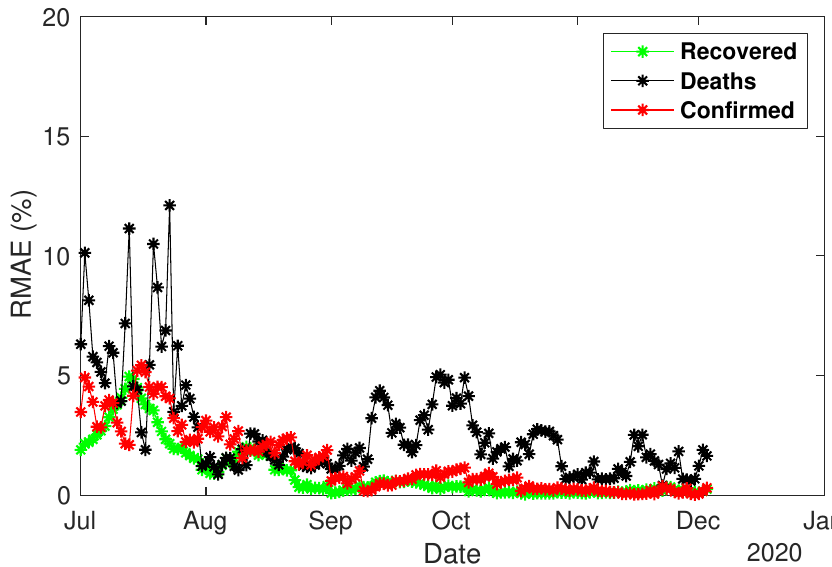
Figure 5. RMAE of the daily two-week forecasts, starting from July 1st until December